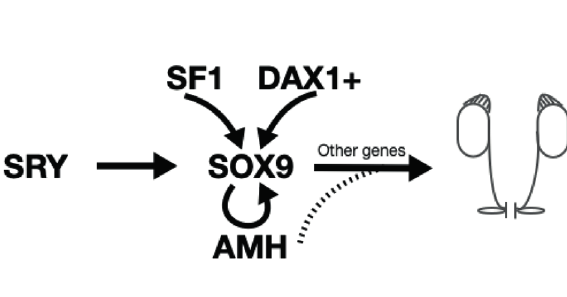
Figure 1 - In normal XY males, the SRY gene begins testicular differentiation by interacting with other genes that determine sex, after which the differentiation and proliferation of Sertoli cells that secrete anti-Müllerian hormone (AMH) promote the regression of the Müllerian ducts and allow the differentiation of the Wolff ducts that will originate the vas deferens, the epididymis, seminal vesicles and ejaculatory ducts. SRY (Sex Determining Region Y), SOX9 (SRY-Box 9), DAX-1 (also know as NR0B1- Nuclear Receptor Subfamily 0 Group B Member 1), AMH (Anti-Mullerian